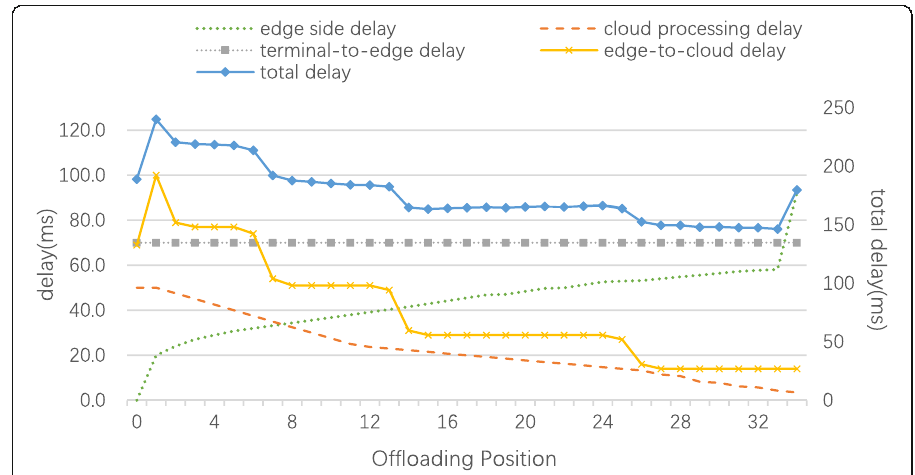
Fig. 6 Delay at the different offloading position. The time latency at the different offloading positions in the ResNET-34